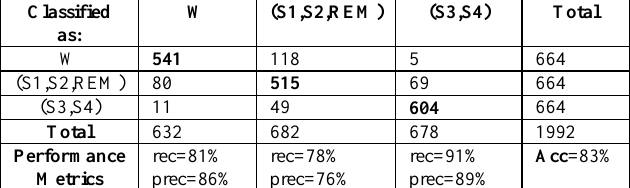
SVM CONFUSION MATRIX WITH UNBALANCED